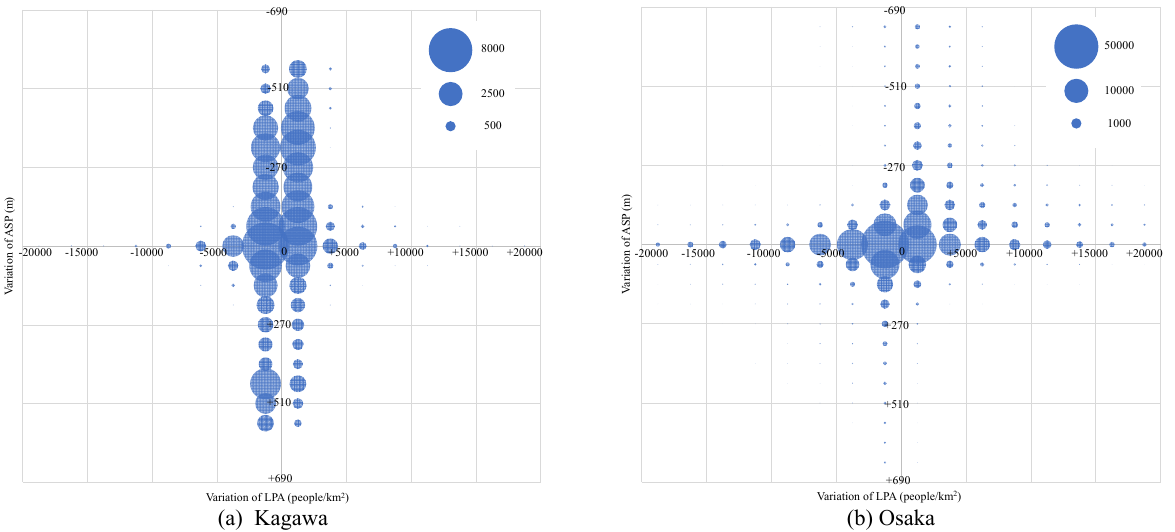
Figure 9 . Bubble charts consisting of the number of points and the variations of LPA and ASP. The size of bubble shows the number of points fell into each interval: ASP of 60m and LPA of 2500 people/km 2